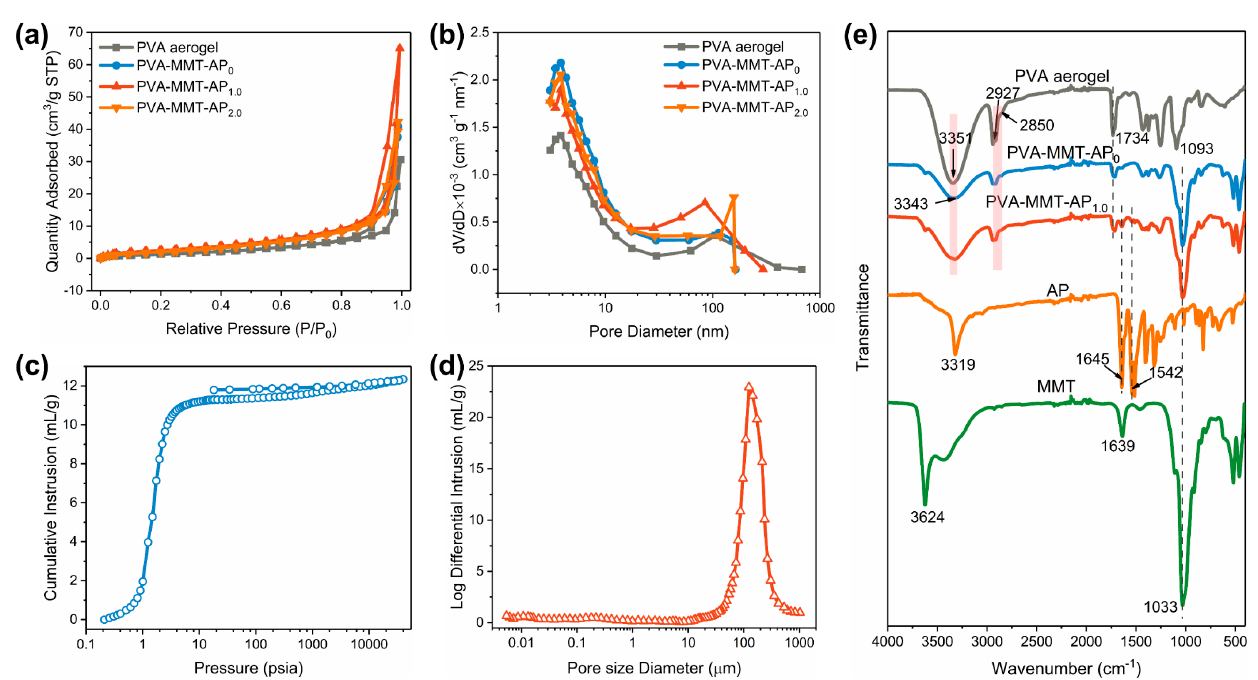
Figure 2. ( a ) N 2 adsorption–desorption isotherms and ( b ) pore size distribution of PVA aerogel, PVA-MMT-AP 0 , PVA-MMT-AP 1.0 and PVA-MMT-AP 2.0 . ( c ) Mercury intrusion–extrusion isotherms and ( d ) pore size distribution of PVA-MMT-AP 1.0 . ( e ) FTIR spectra of AP, MMT, PVA aerogel, PVA-MMT-AP 0 and PVA-MMT-AP 1.0 .